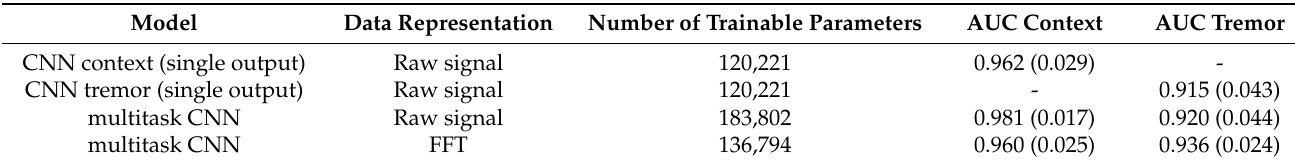
Table 8. Comparison of the number of trainable parameters and the performance of the convolutional models. Model Data